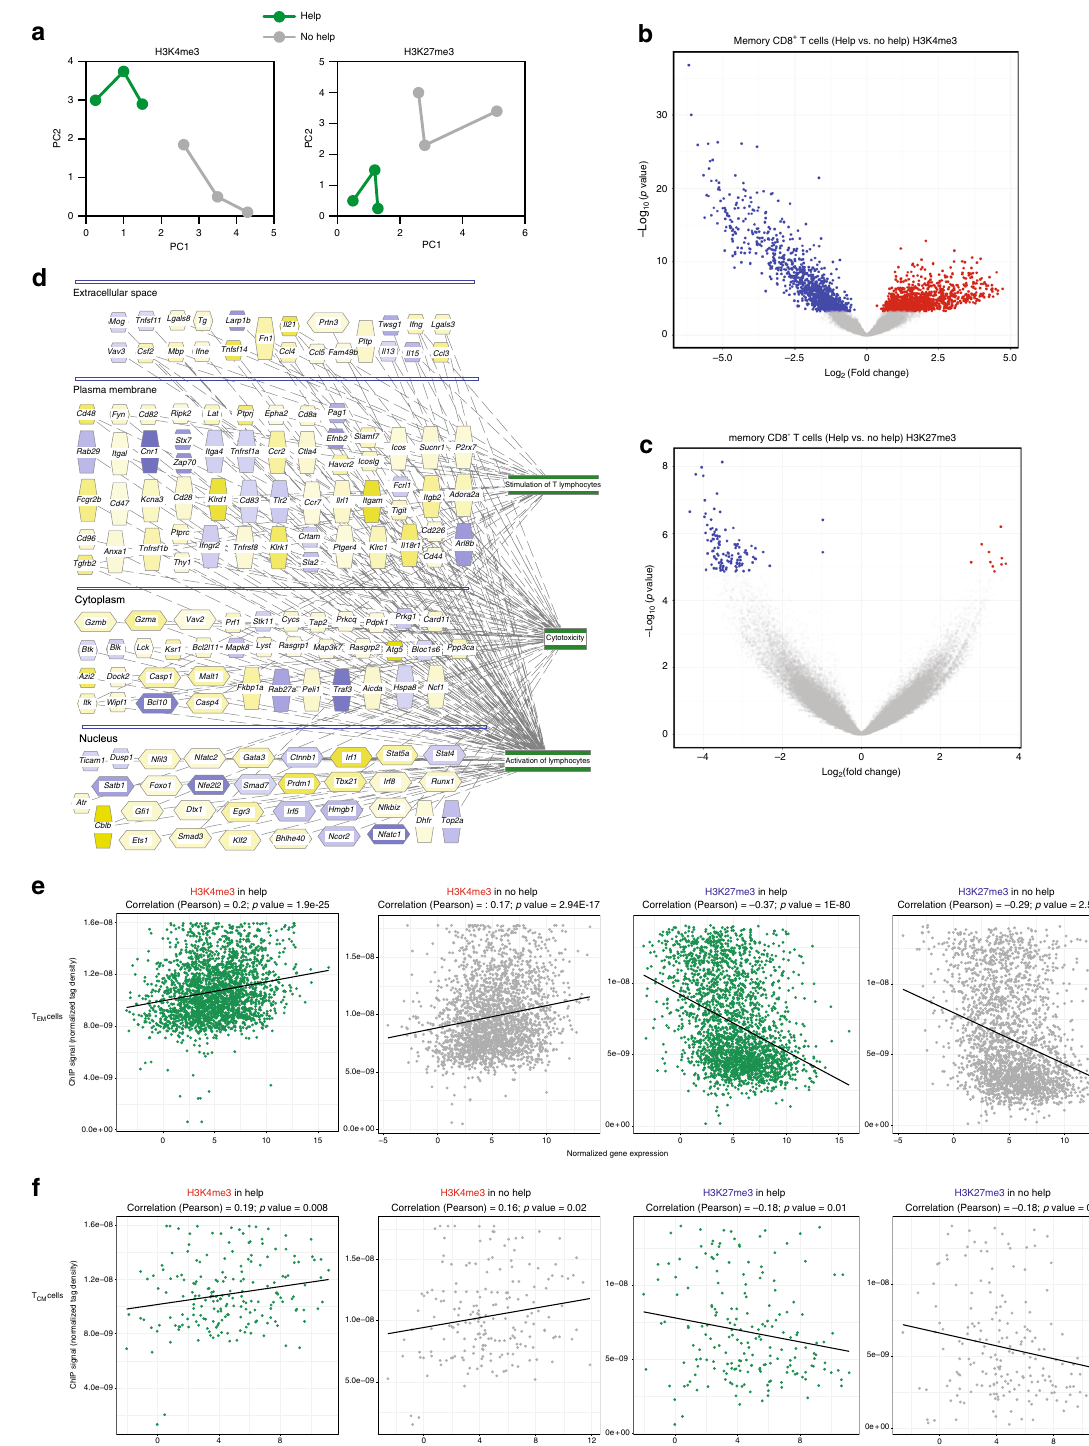
Fig. 6 Help delivered during priming leaves an epigenetic imprint in steady-state memory cells. Mice ( n = 3 per group) received Help or No Help vaccine on days 0, 3, and 6. At day 100, E7-speci fi c memory CD8 + T cells were isolated from the spleens and subjected to ChIPseq analysis with antibodies against H3K4me3 and H3K27me3. a PCA plots depicting results of ChIPseq analysis. b , c Volcano plots depicting differentially modi fi ed regions (DMRs) as designated by H3K4me3 ( b ) or H3K27me3 ( c ) marks. Blue and red dots indicate DMRs with signi fi cant differential modi fi cations (FDR < 0.05). d Molecules differentially modi fi ed by H3K4me3 in helped memory E7-speci fi c CD8 + T cells, as assigned to functional categories and annotated for subcellular localization by IPA. e , f Correlation between differential mRNA expression in helped versus non-helped T EM ( e ) and T CM ( f ) cells and histone methylation in gene bodies and regions maximally 1 kb upstream from the TSS. Normalized tags of H3K4me3 and H3K27me3 are shown versus average normalized mRNA expression values in helped versus non-helped T EM ( e ) and T CM ( f ) cells (described in Fig. 5).